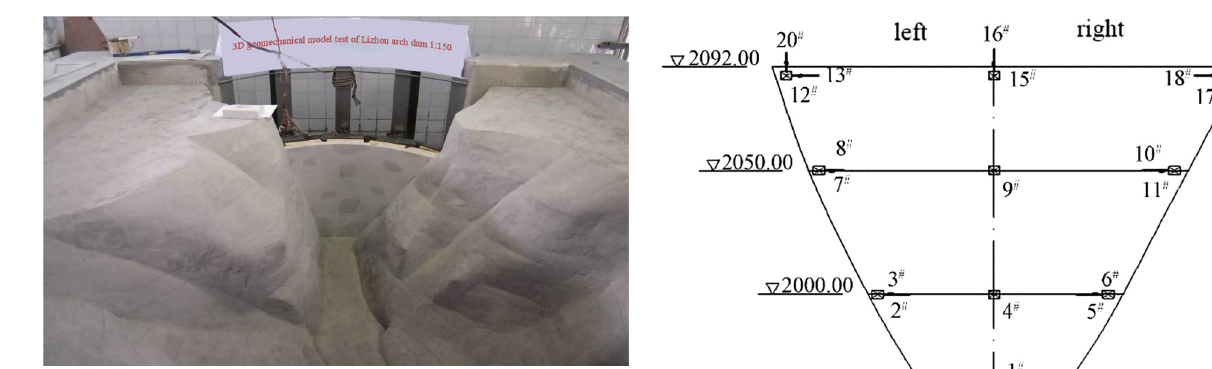
Figure 3: The model